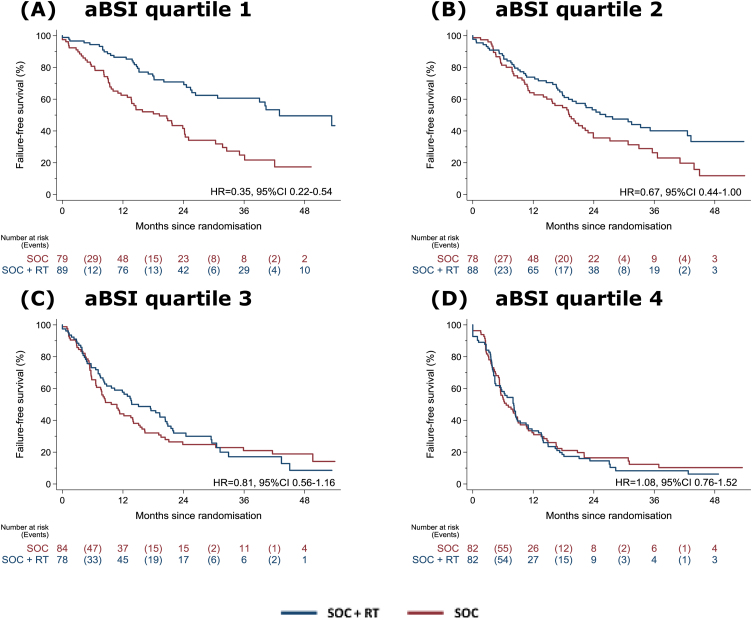
Kaplan-Meier plots for failure-free survival by treatment in (A–D) aBSI quartiles 1–4. aBSI = automated bone scan index; RT = radiotherapy; SOC = standard of care.